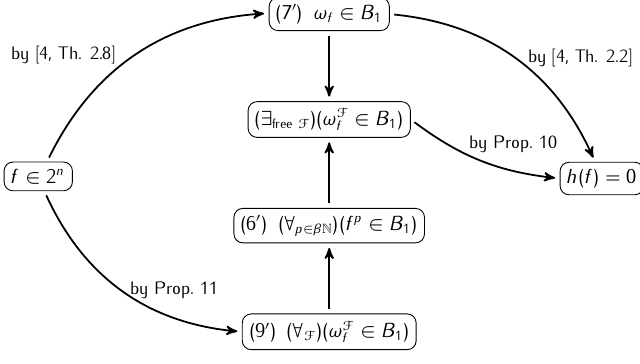
Figure 1. Dependencies between notions used in Theorem 7, Problems 8 and 9, and Propositions 10 and 11. Arrows denote implications.